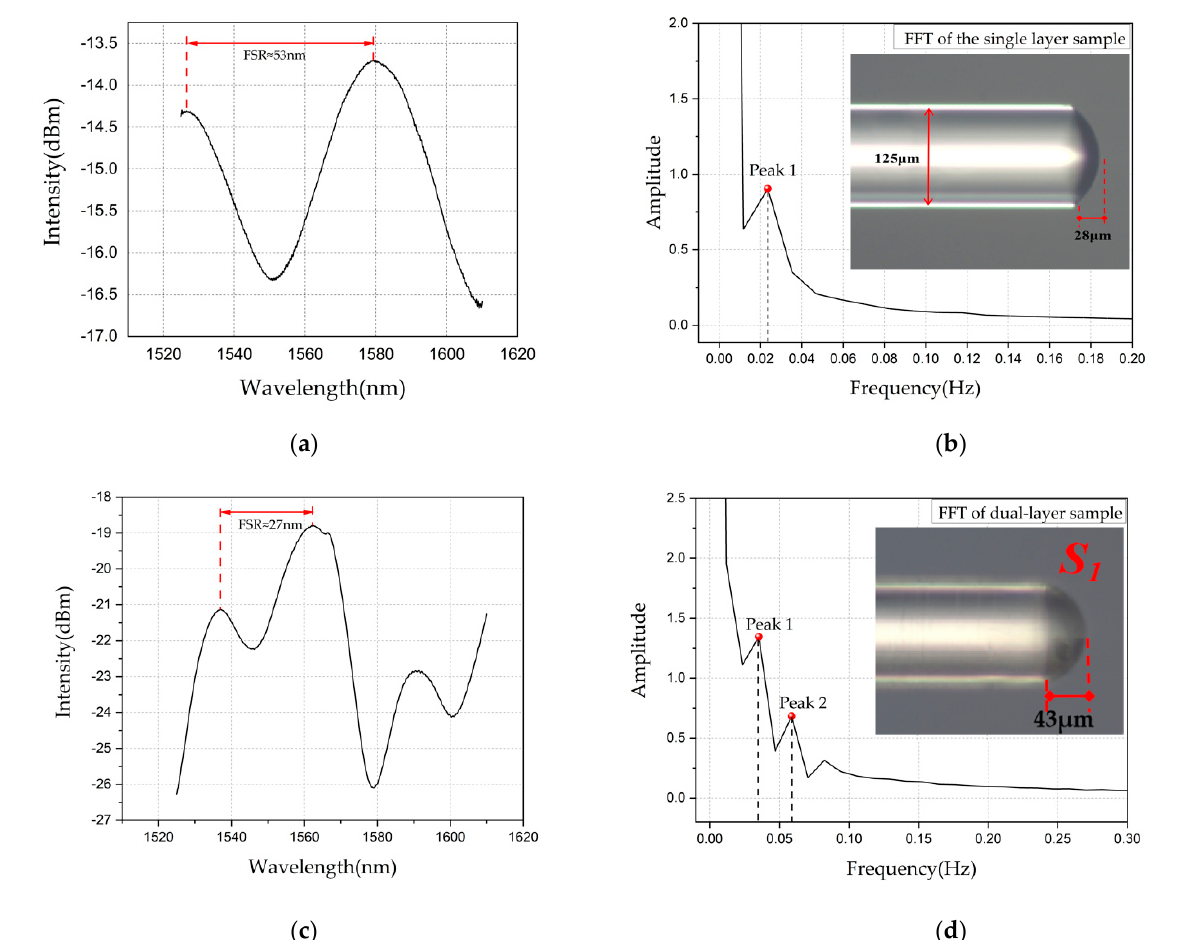
Figure 4. Comparison of the fabricated FP sensors: ( a ) the interference spectrum of a single cavity sensor; ( b ) the Fourier transform spectrum of Figure 4a; ( c ) the interference spectrum of a dual cavities sensor S 1 ; and ( d ) the Fourier transform spectrum of S 1 .